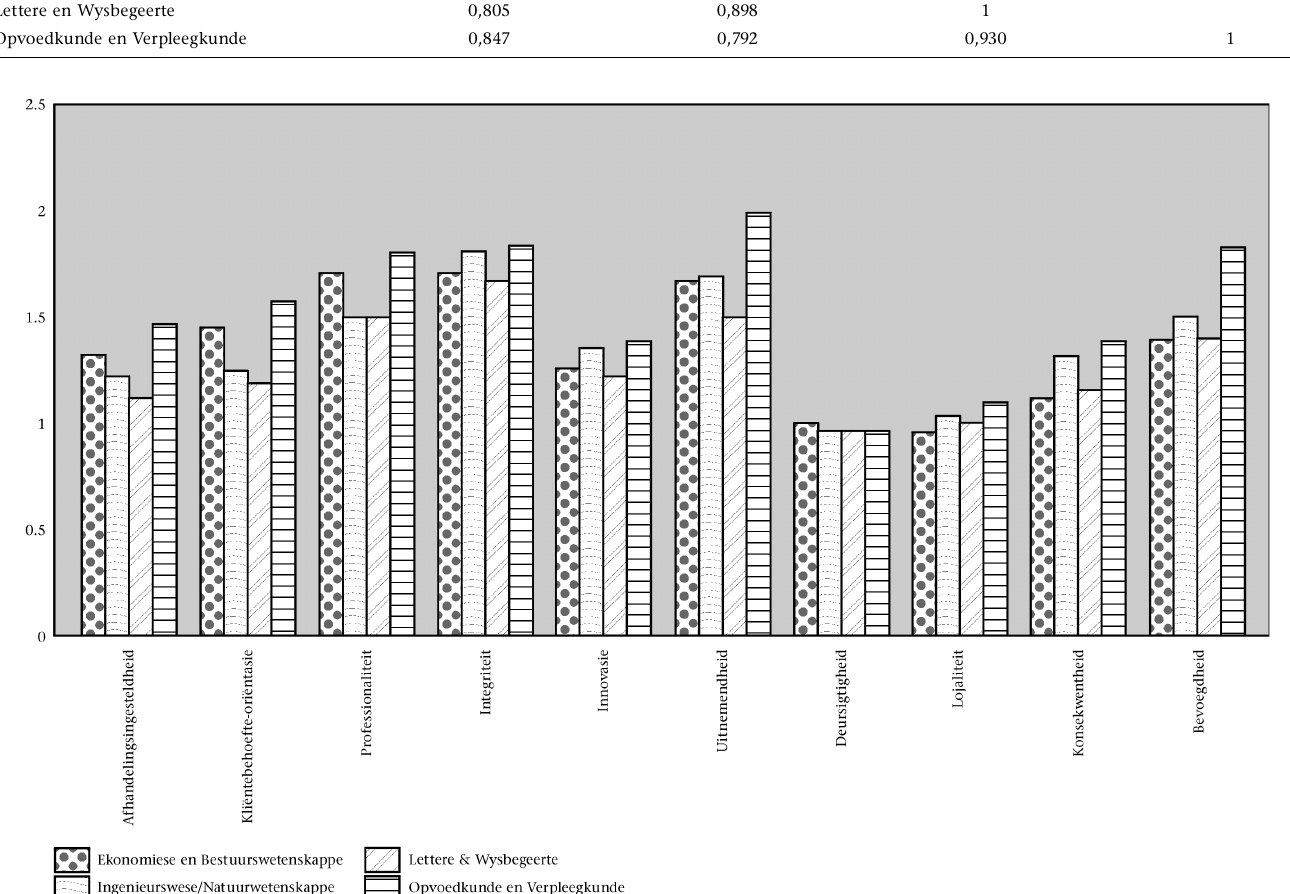
Figuur 2: Skaalwaardes ten opsigte van die verskillende